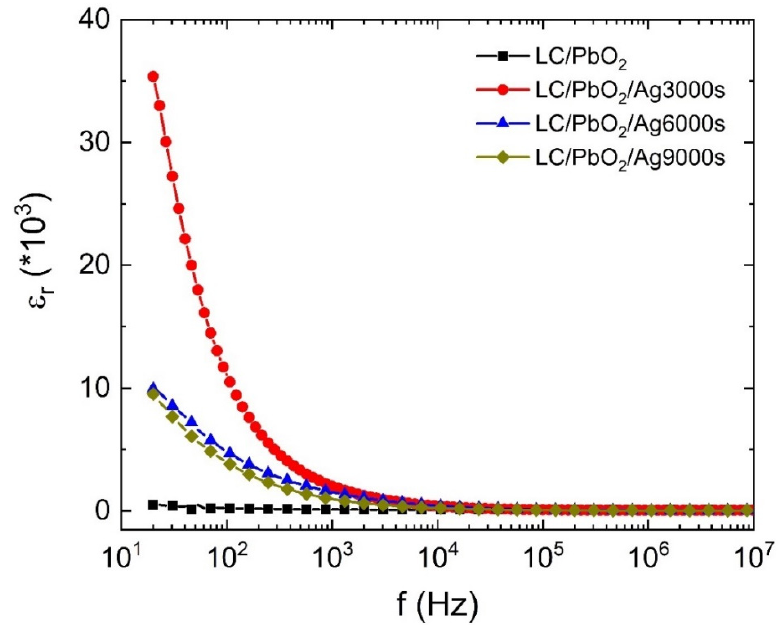
Figure 3. The dielectric constant of LC \ PbO 2 , LC \ PbO 2 \ Ag for 3000 s, LC \ PbO 2 \ Ag for 6000 s, and LC \ PbO 2 \ Ag for 9000 s .